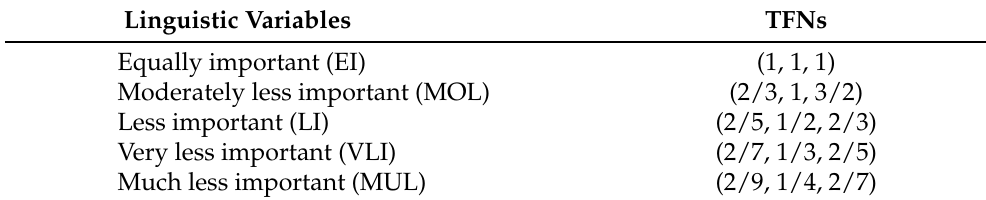
Table 3. For weighting criteria, linguistic characteristics are used. Linguistic Variables TFNs Equally important